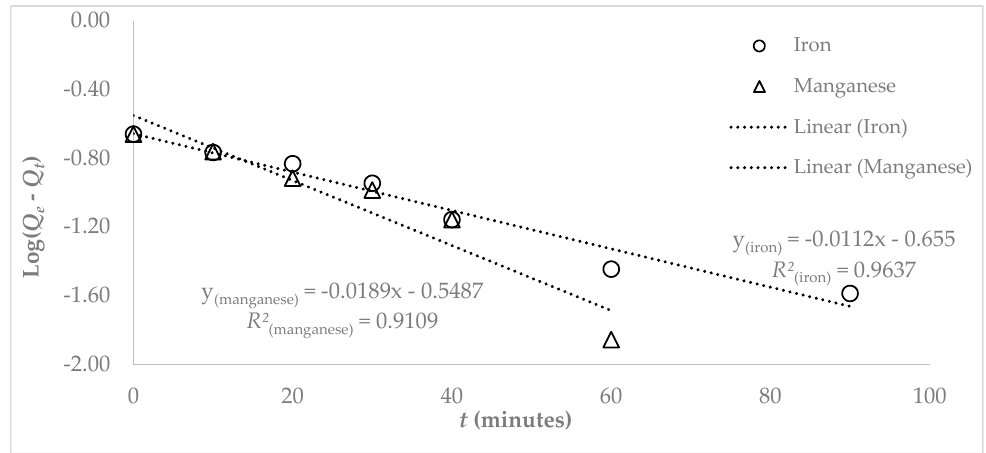
Figure 10. Pseudo first-order kinetic model obtained for adsorption of iron and manganese on to zeolite Y. Initial Fe = 1.15 mg L − 1 ; Initial Mn = 1.61 mg L − 1 ; adsorbent dose = 2 g L − 1 , T = 25 ◦ C; water pH =